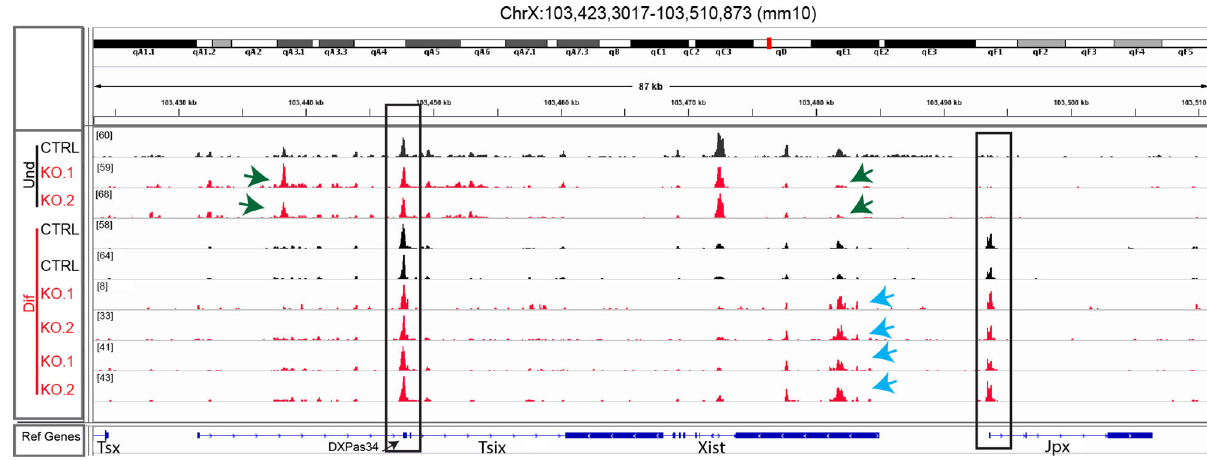
Fig. 4 ATAC-seq analysis zoom at the Xist locus. Zoom-in on the XIC around the Xist and Tsix genes. In black the parental cell line and in red two representative KO cell lines (C4.1/C4.3 sub-clones). Undifferentiated and differentiating ES cells are shown (Und/Dif). Light-blue arrows indicate changes in chromatin structure at the Xist promoter in differentiating cells. A black box surrounds the Tsix and Jpx main regulatory regions, indicates no change of chromatin structure. Green arrows indicate chromatin changes around the Tsix promoter/ Tsix intron and Xist promoter, (CTRL, parental cell line: Fa2L-S4; Chd8 KO.1, sub-clone C4.1; Chd8 KO.2, sub-clone